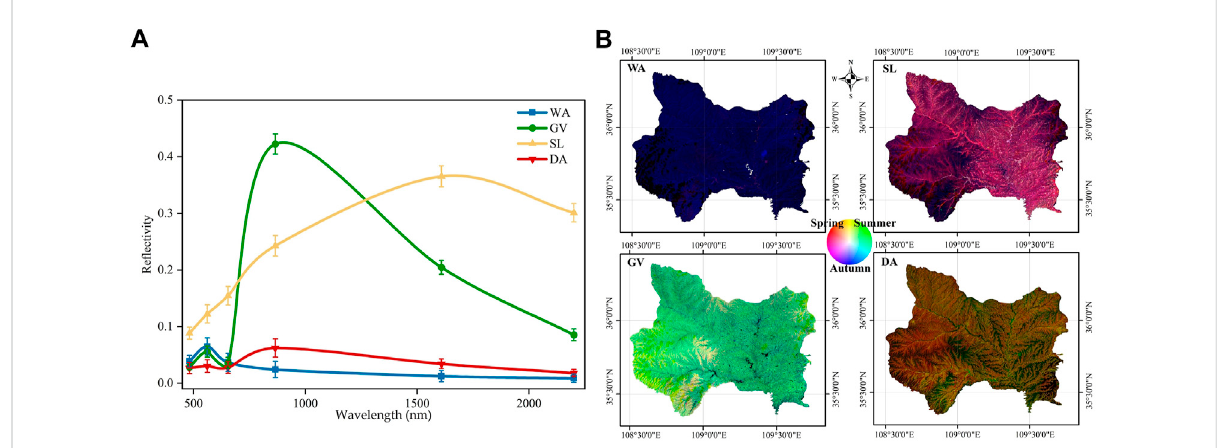
FIGURE 3 The standard spectral curves and fractional abundance of four endmembers. (A) The four endmembers include soil (SL, rock and soil), green vegetation (GV, green photosynthetic leaves), dark (DA, shadow of mountains and vegetation) and water (WA); (B) three-temporal false color composite images, where red, green, and blue represent endmember fractional abundance in spring, summer and autumn,